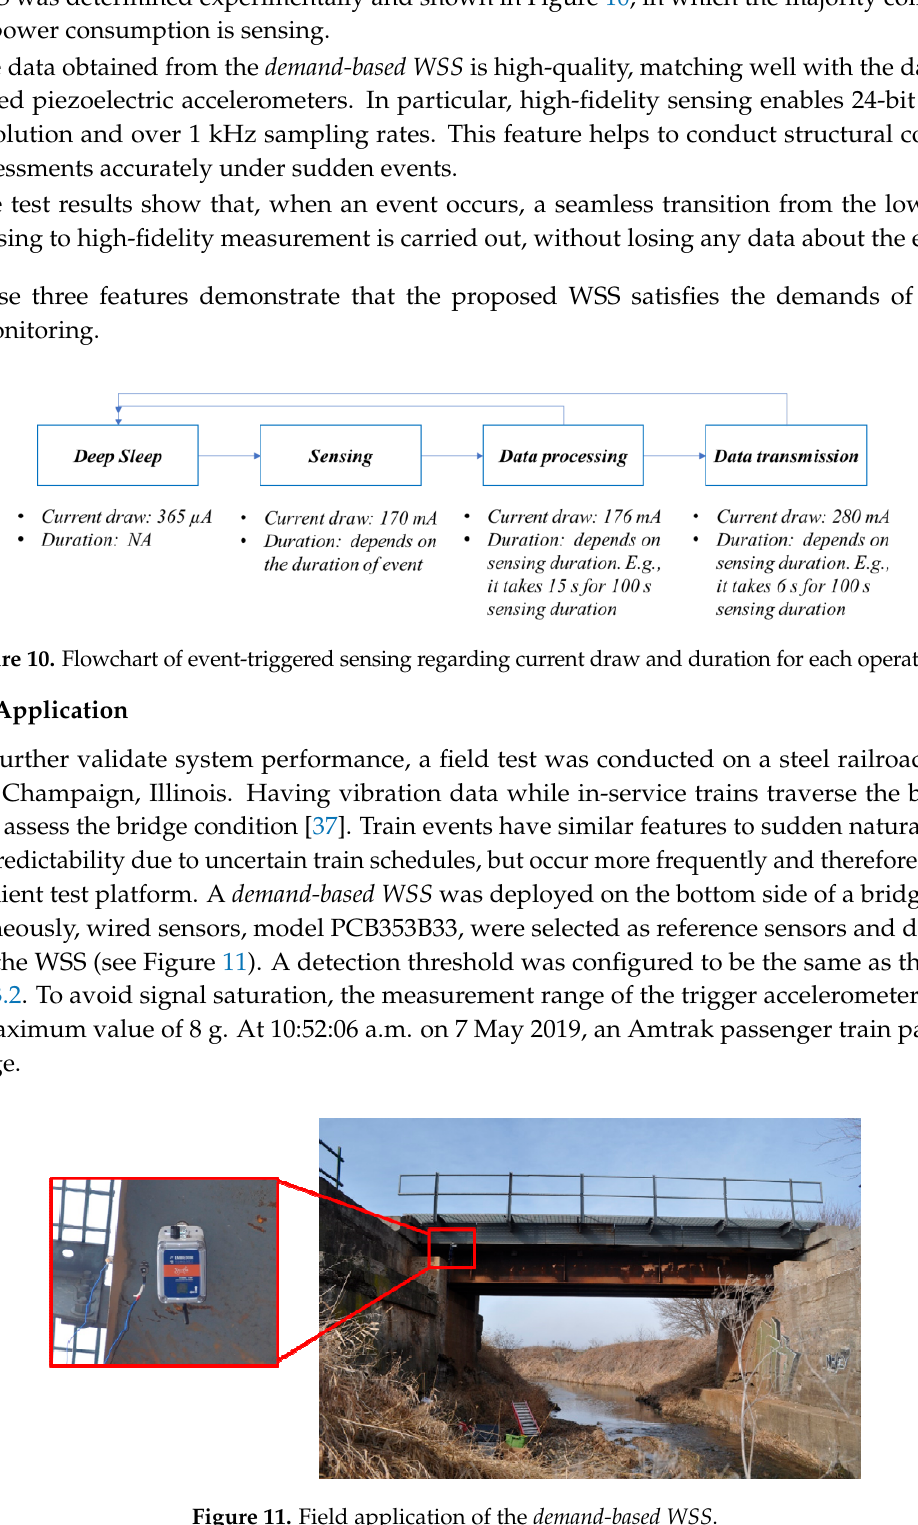
Figure 11. Field application of the demand-based WSS.